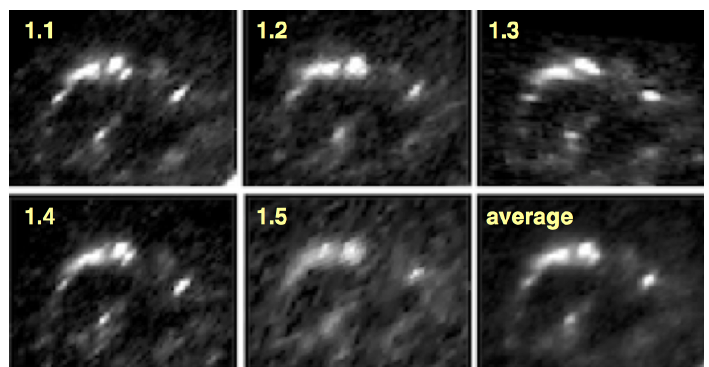
Figure 4. Back-projected multiple images of MIS 1 to the source plane using the distortion matrix of local lens properties of Equation (8) for each image, normalised such that the transformation between 1.1. and 1.2 has unit determinant. Comparing the back-projections for images 1.1 and 1.5, we see that highly-resolved, large images with high signal-to-noise ratio (SNR) yield higher resolutions in the source reconstruction than smaller images with a low